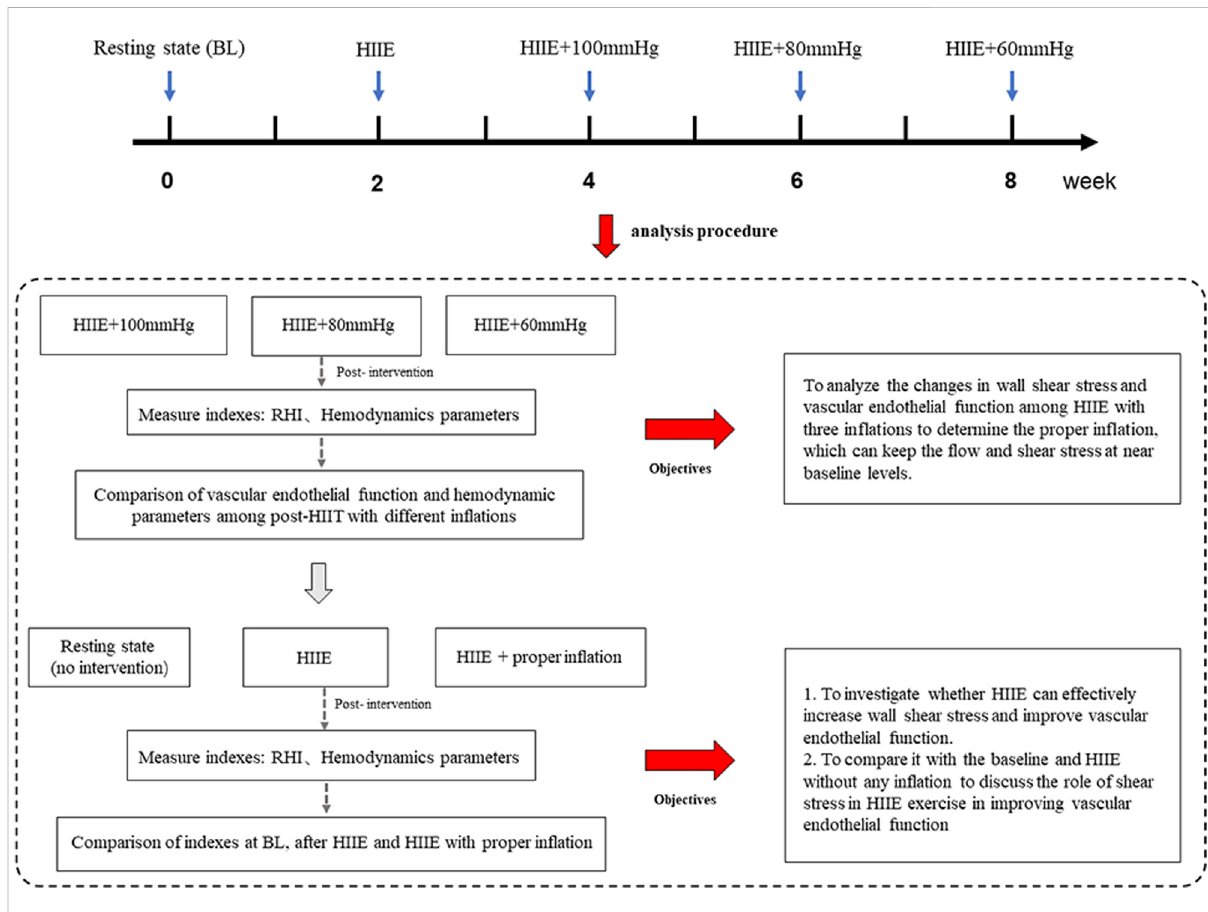
FIGURE 1 The experimental design. Note: HIIE + 100 mmHg, HIIE with 100 mmHg in fl ation; HIIE + 80 mmHg, HIIE with 80 mmHg in fl ation; HIIE + 60 mmHg, HIIE with 60 mmHg in fl ation; RHI, reactive hyperemia